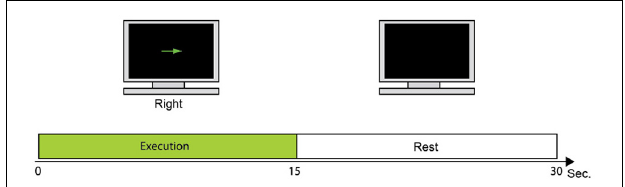
FIGURE 2 | fMRI task. During 15s, the participant moves the right index finger in the instructed direction every 1s. The monitor then goes blank and the participant takes a break for 15s while watching the monitor.